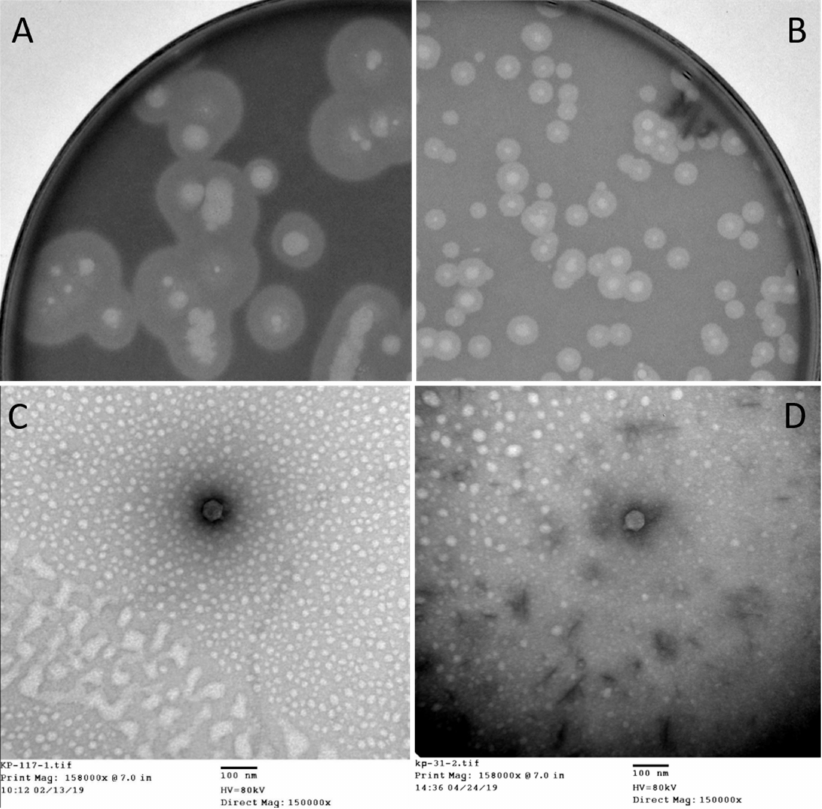
Figure 2. Plaque morphology images of ( A ) phage 117 and ( B ) 31. Plaques were observed in two distinct sizes. For (A) phage 117, the majority of plaques were ca. 0.8 cm in diameter; however, the plaques of (B) phage 31 were ca. 0.3 cm in diameter. The morphology of phage 117 plaques is consistently “halo” shaped. Transmission electron microscopy micrographs of bacteriophages: ( C ) phage 117 and ( D ) phage 31 classifying them to Podoviridae family. Scale bar, 100